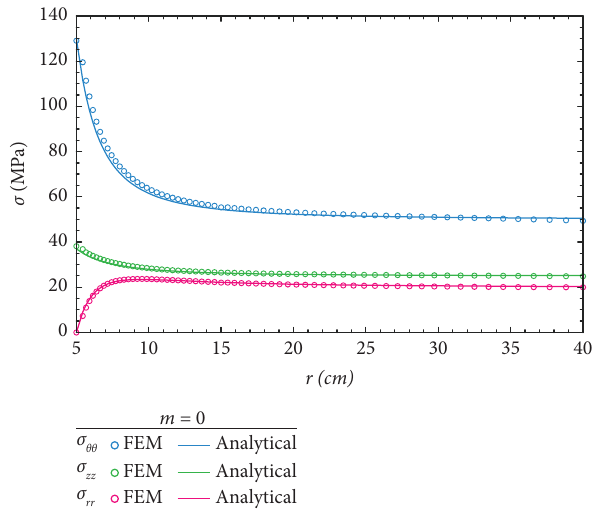
Figure 7: Te stresses along the minimum in situ stress ( θ � 0 0 )